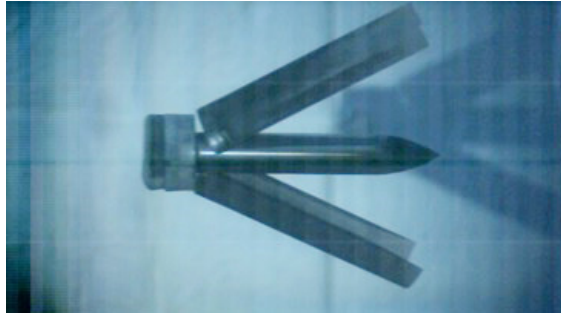
Figure 9. The flight attitude of the projectile.